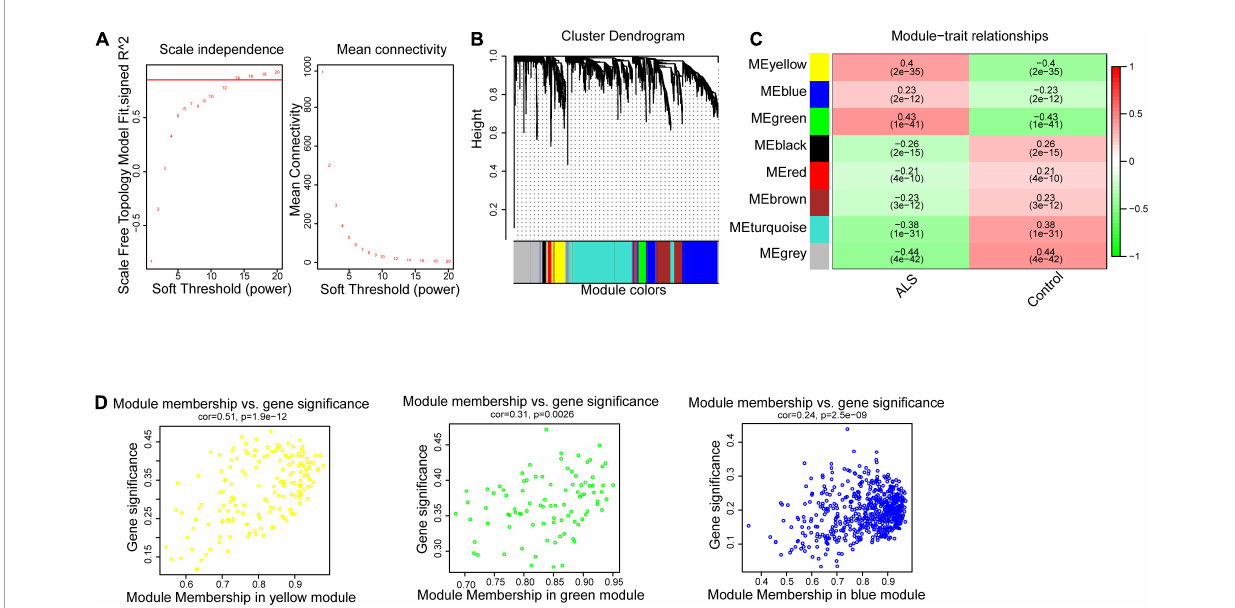
FIGURE3 Weighted gene correlation network analysis (WGCNA). (A) The scale-free fit index for soft-thresholding powers. The scale-free R 2 > 0.9 was used as a criterion to construct a soft threshold power for appropriate networks. (B) A dendrogram of co-expressed gene modules. The branches in the graph are clustered into eight modules, designated by each color below. (C) A heatmap shows the association between each module eigengene and phenotype. The coefficient in each cell is the correlation, decreasing from red to green. Yellow, green, and blue three modules are positively correlated with ALS. (D) Scatter plot of module eigengenes in the yellow, green and blue modules. All these three modules were significantly associated with ALS ( p <